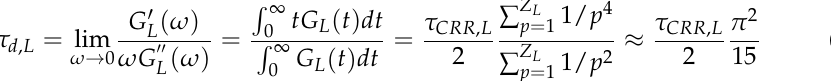
and horizontally shifted by a factor